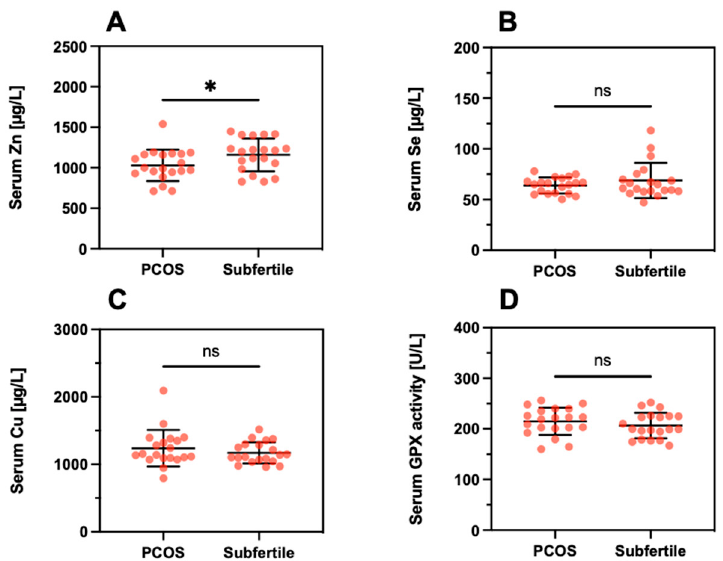
Figure 7. Serum trace element concentrations and GPX3 activity in relation to PCOS. The direct comparison of serum ( A ) Zn, ( B ) Se, ( C ) Cu, and ( D ) GPX3 activity indicates minor differences only, with the notable exception of a slightly suppressed serum Zn concentration in PCOS. Tested with a linear mixed model; * indicates p < 0.05. ns indicates no significant difference.